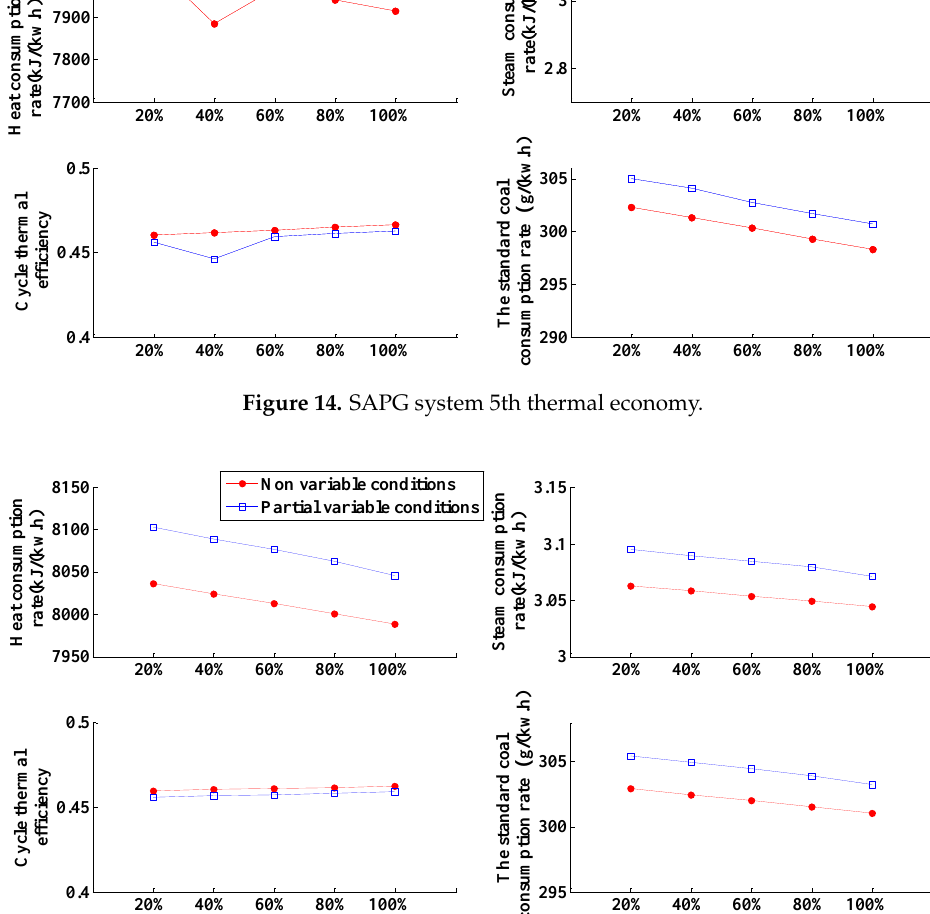
Figure 15. SAPG system 6th thermal economy.